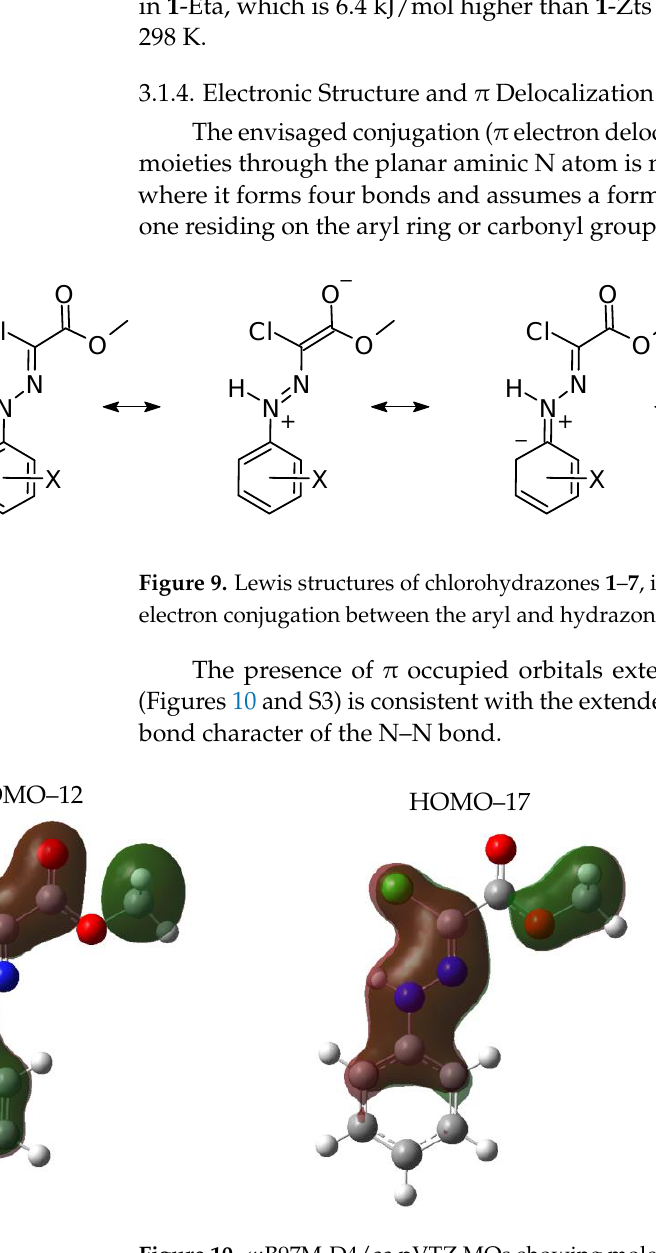
11 Figure 8. Model systems used to investigate the ( E , Z) isomerism of 1 . Table 5. Free energy difference between Z and E isomers of the pro-systems, calculated at the ω B97M-D4/cc-pVTZ level. R 1